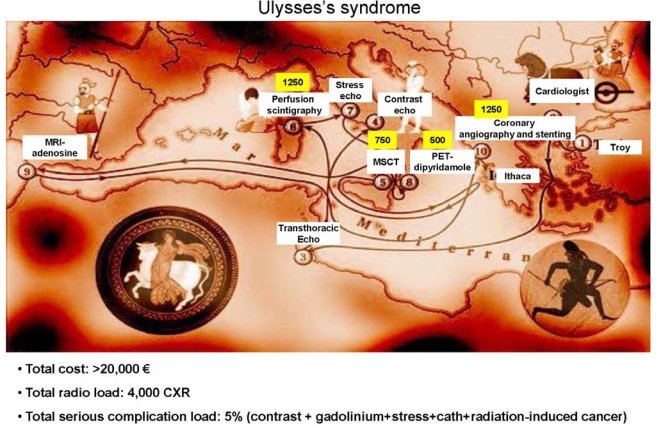
Ulysses’ voyage as a metaphor for the diagnostic pathway of the patient with suspected coronary artery disease. At the end of the first round of this odyssey, the cumulative cost is more than 100 times a simple exercise-electrocardiography. The cumulative radiation dose is that of more than 4,000 chest x-rays. The cumulative damage (including acute, subacute, and long-term risks) will cause a serious health detriment (including infarction, renal insufficiency, or cancer) in about 5–10% of patients.